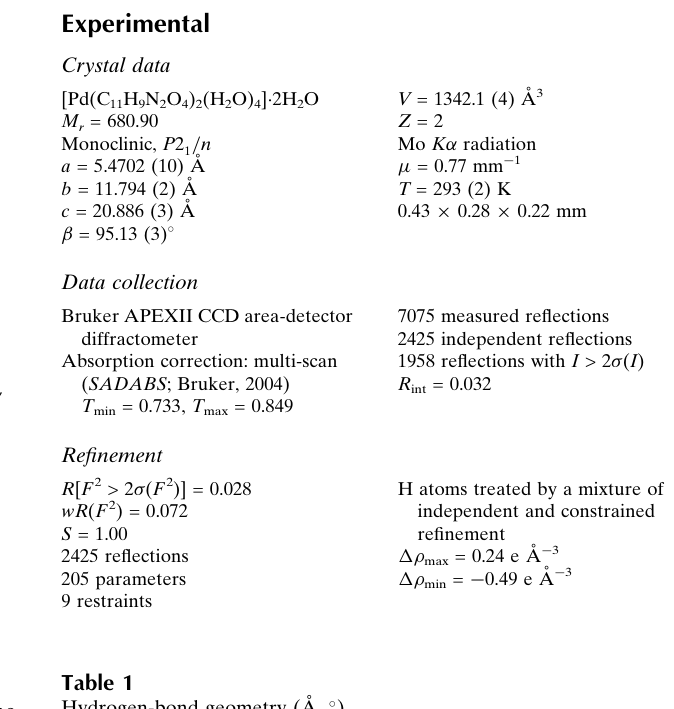
Hydrogen-bond geometry (A˚ , (cid:2)